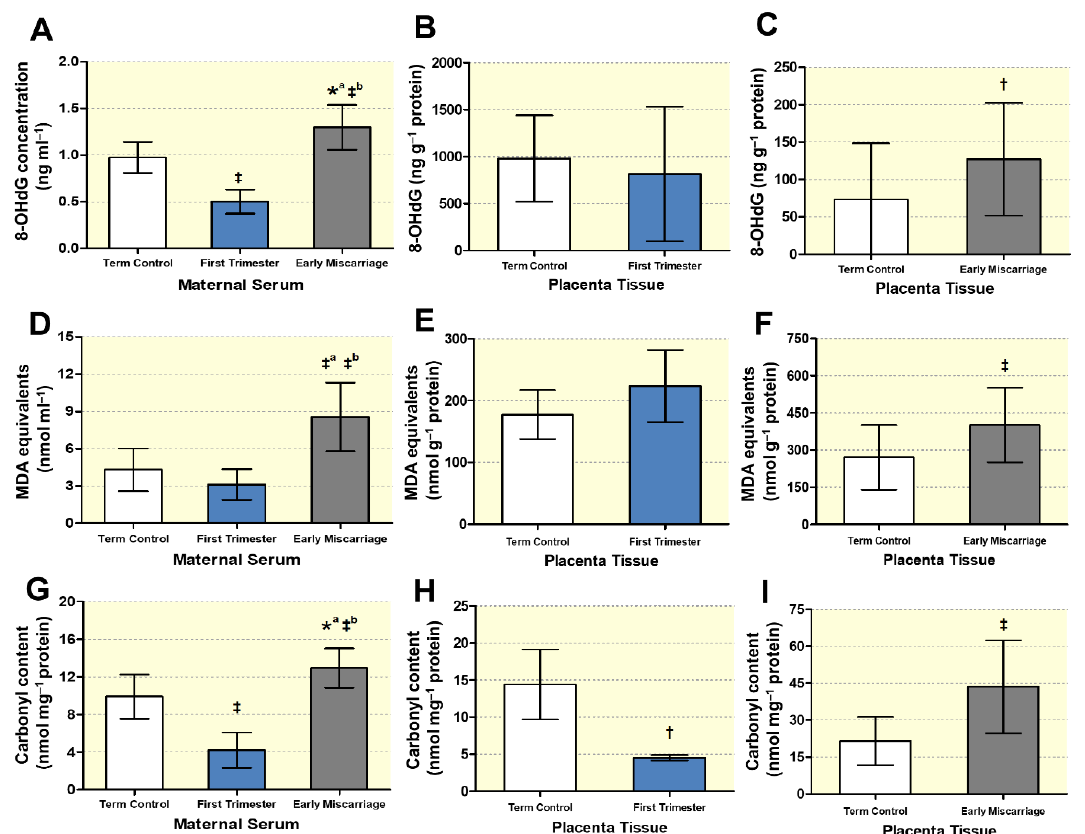
Figure 7. Analysis of oxidative stress markers. ( A )–( C ): Measurement of 8-OHdG protein levels by ELISA in ( A ) maternal serum of term controls, first trimester, and EMC (n = 19, n = 20, and n = 20, respectively), ( B ) placental tissue of first trimester and term controls (n = 5 and n = 6, respectively; Swiss cohort), and ( C ) placental tissue of EMC patients and term controls ( n = 19 and n = 20, respectively). ( D – F ): Analysis of lipid oxidative damage as formation of malondialdehyde (MDA) equivalents in ( D ) maternal serum of 1st trimester, EMC patients, and term control (n = 20, n = 20, and n = 19, respectively), ( E ) placentae of first trimester and term controls (n = 6 and n = 5, respectively; Swiss cohort), and ( F ) placentae of EMC and term control ( n = 20 and n = 19, respectively). ( G – I ): Measurement of protein carbonylation in ( G ) maternal serum of term controls, 1st trimester, and EMC ( n = 19, n = 20, and n = 20, respectively), ( H ) placentae from first trimester and term controls ( n = 6 and n = 5, respectively; Swiss cohort), and ( I ) EMC patients and term controls ( n = 20 and n = 19, respectively). Data are presented as mean ± SD for each group. The statistical analysis in ( A , D , G ) was performed by Kruskal–Wallis test followed by Dunn’s multiple comparison test. In ( B , C , E , F , H , I ), statistical evaluation was performed by using the two-tailed Mann–Whitney test for comparing first trimester vs. term controls (Swiss cohort) and EMC vs. term controls, respectively. ‡ ( p ≤ 0.001), † ( p ≤ 0.01), * ( p ≤ 0.05). ‡ a : significance between EMC and term control; * a significance between EMC and term control; ‡ b : significance between EMC and first